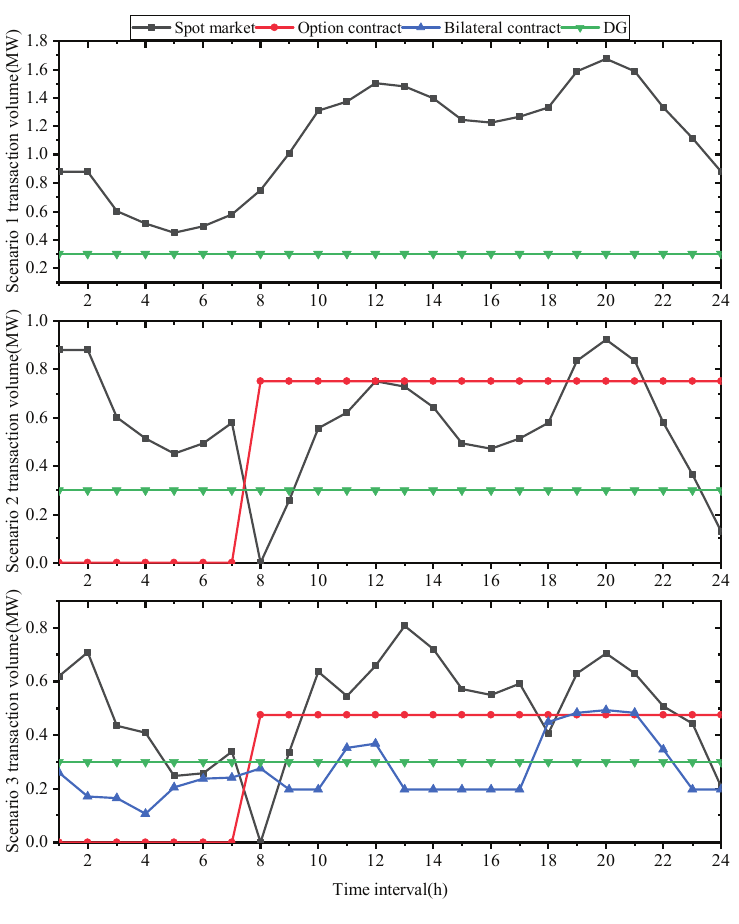
Figure 4. DSO electricity transaction strategy in different scenarios.